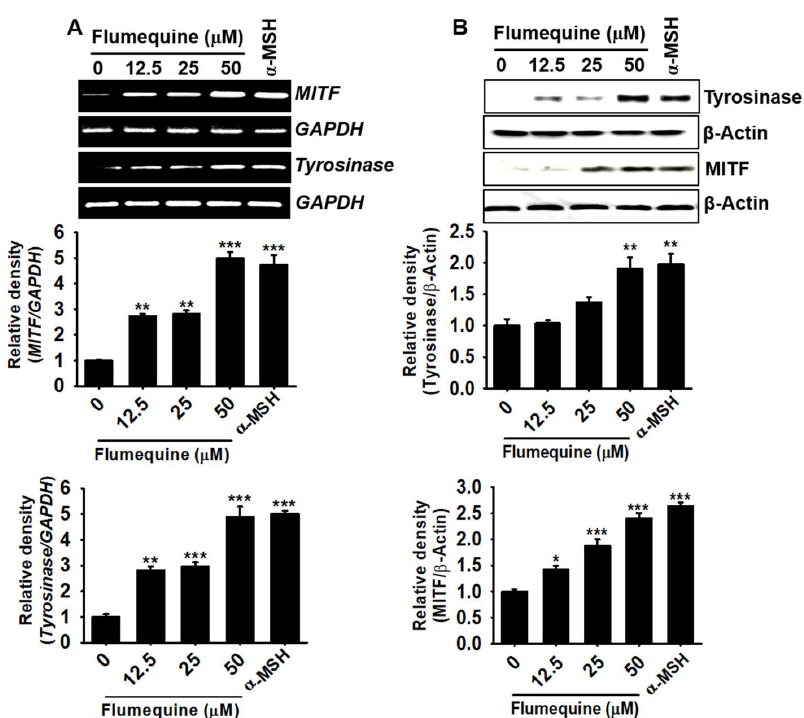
Figure 4. Flumequine stimulates microphthalmia-associated transcription (MITF) and tyrosinase expression in B16F10 cells. ( A ) B16F10 cells were exposed to flumequine (0–50 μM) for 48 h and the expression of MITF and tyrosinase was measured. ( B ) Under the same experimental condition, the protein expression of MITF and tyrosinase was measured by western blotting analysis at 72 h. The α-melanocyte stimulating hormone (α-MSH)-treated group was used as a positive control. The results are the average of three independent experiments and are represented as the mean ± SEM. *** , p < 0.001, ** , p < 0.01, and *, p < 0.05 vs. untreated control.